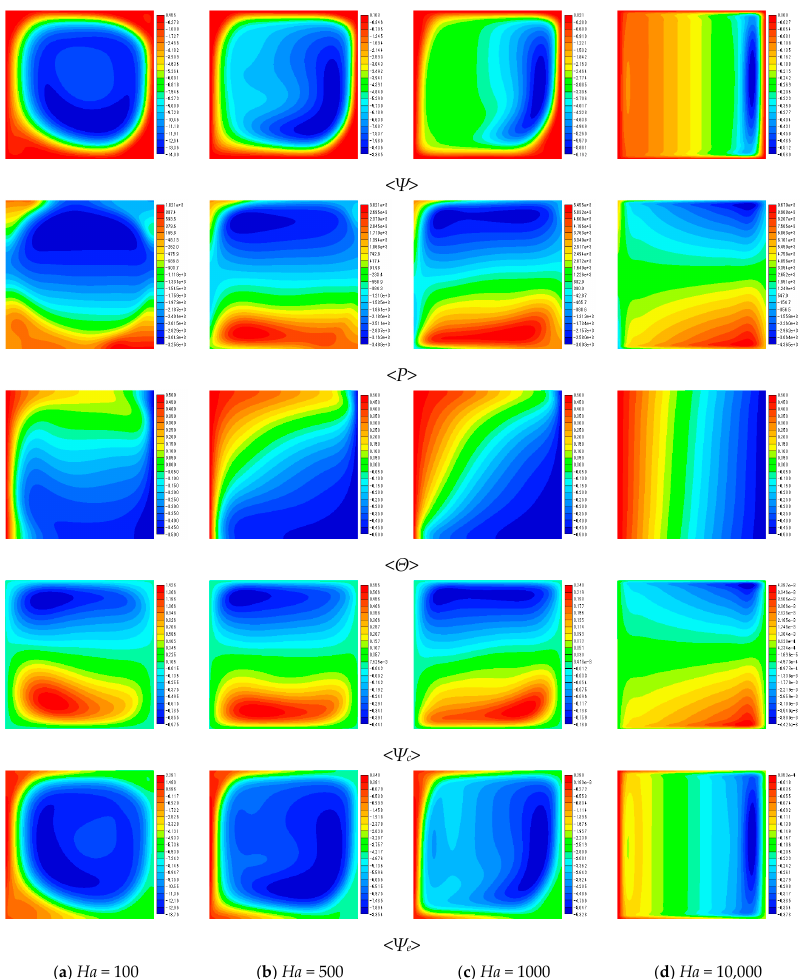
Figure 10. Contour figures for several values of Hartmann number at κ = 0.5 and Ra = 5 × 10 5 . From top to bottom, stream function of velocity, pressure, temperature, stream function of electric current density, and electric potential are shown.